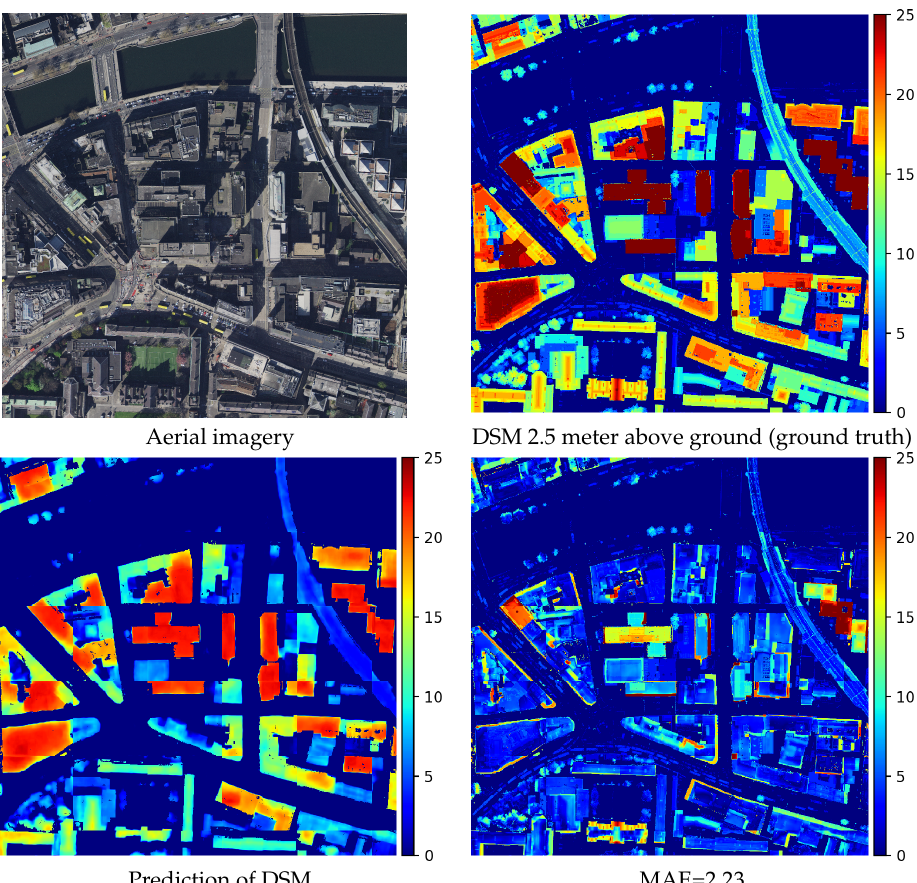
Figure 10. DSM of a 500 × 500 m tile in the Dublin inner city center with northing of 316,000 to 316,500, and easting from 234,000 to 234,500, in TM65 projection.